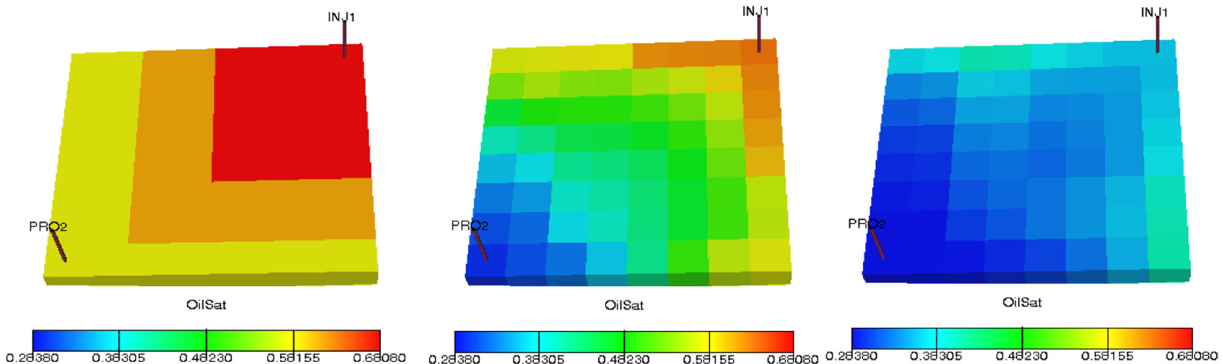
Fig. 7 Oil saturation charts for injecting into thin layers and producing from thick ones